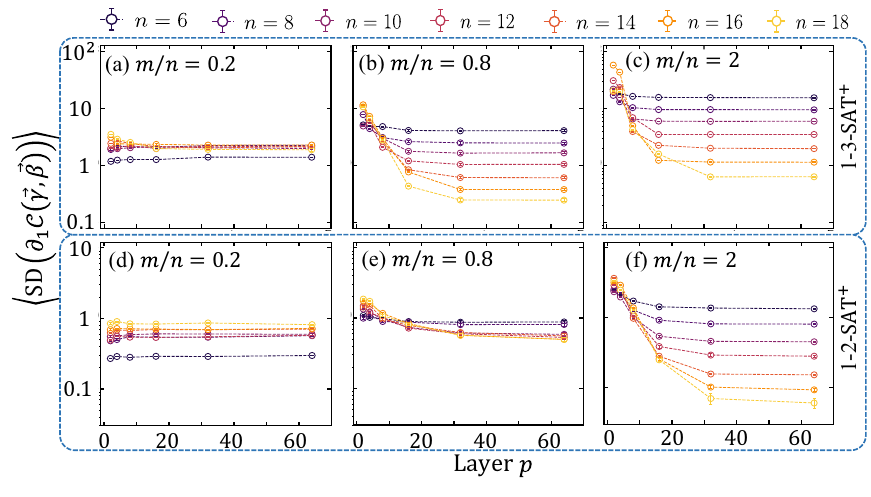
Fig. 3 Barren plateau. SD of gradient SD ∂ 1 C γ ; β ð Þð Þ versus the layer of QAOA p for 1-3-SAT + (top, a – c ) for 1-2-SAT + (bottom, d – f ) problems with different number of variables n . From left to right ( a and d , b and e , c and f ) we plot at three different ratios m / n = 0.2, 0.8, 2. Due to the fi nite size n ≤ 18, as shown in Fig. 2 the transition happens at around m / n = 0.8. All results and error bars are estimated over 100